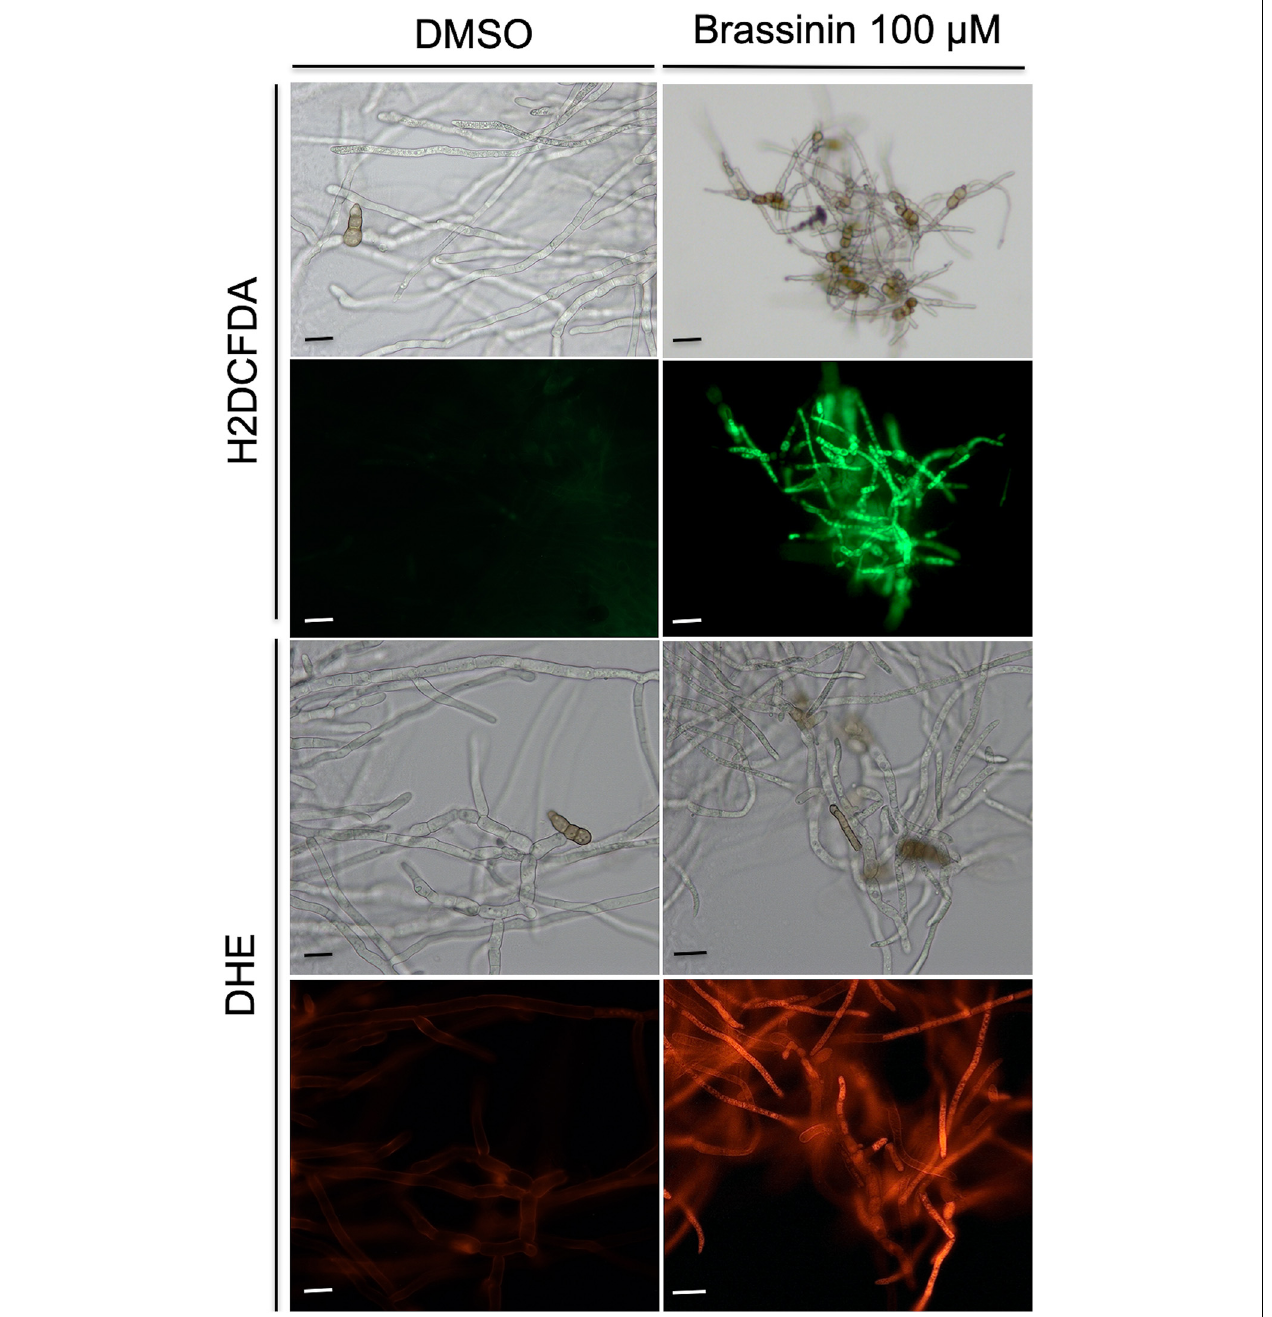
FIGURE 6 | Assessment of oxidative stress within A. brassicicola cells exposed for 30 min to 100 µ M brassinin or to DMSO. The fluorescent dyes H 2 DCFDA and DHE were used to detect the accumulation of ROS within hyphae of germlings treated for 1 h with DMSO (control) or 100 µ M brassininin. For each panel, the bottom part corresponds to fluorescence microscopy and the top part to light-field microscopy. Scale bars = 20 µ